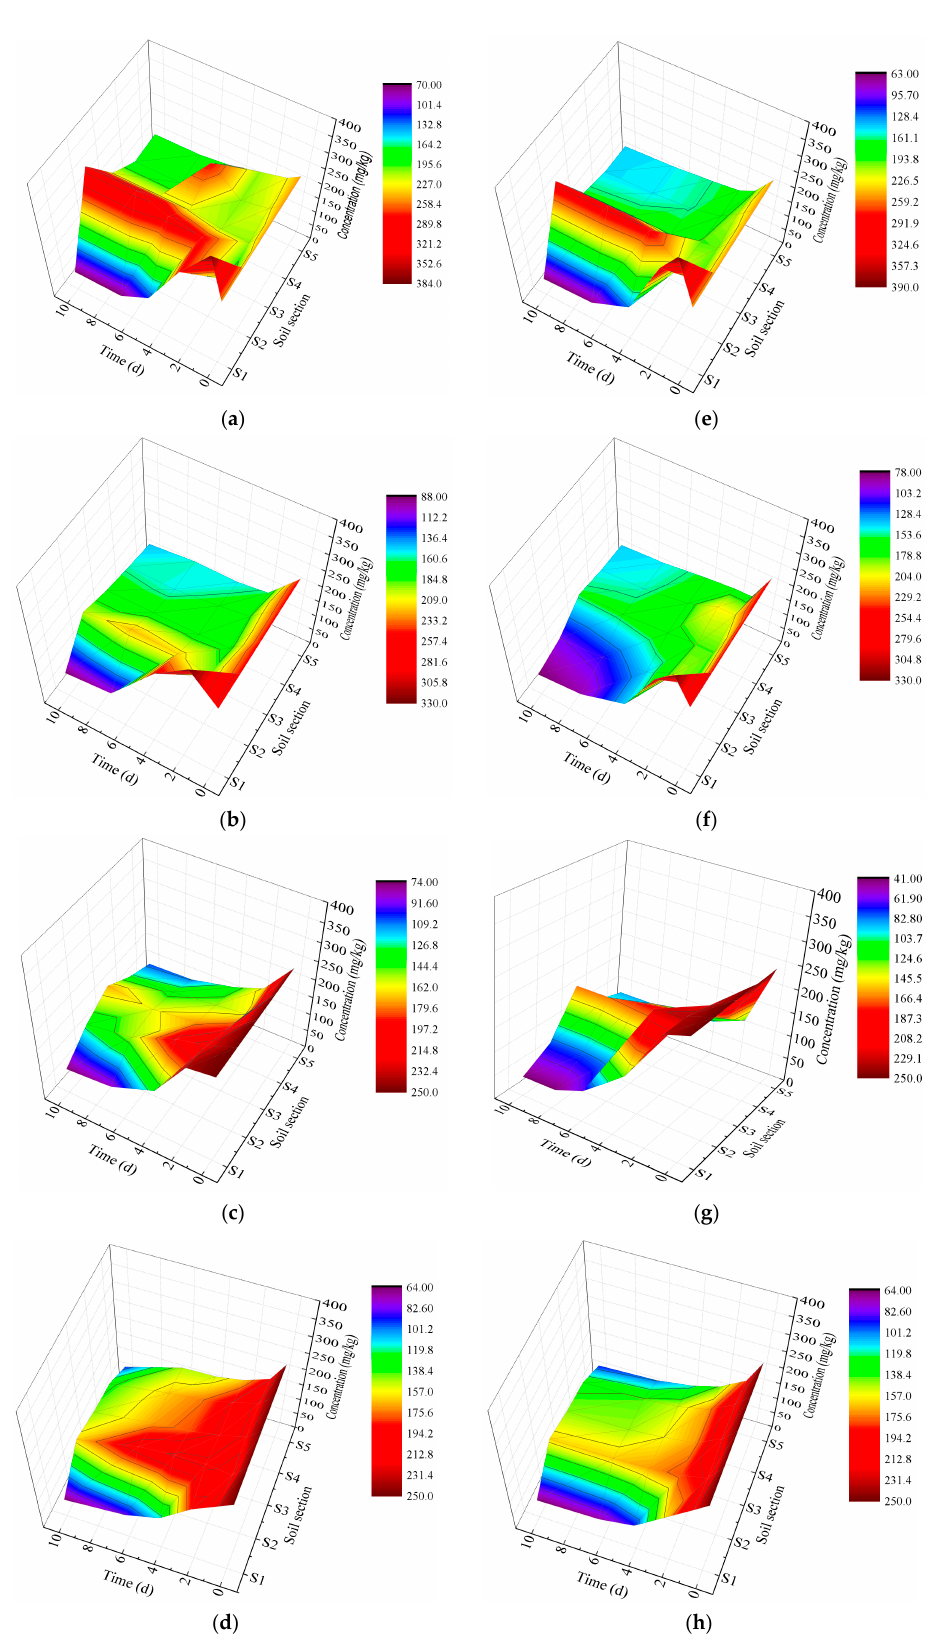
Figure 5. Changes in concentration of contaminants during electrokinetic remediation. ( a ) T1; ( b ) T2; ( c ) T3; ( d ) T4; ( e ) T5; ( f ) T6; ( g ) T7; ( h ) T8. As remediation time goes on, the maximum concentration of Cu ions occurs in the S2-S4 sections because the soil near the anode is gradually acidified, causing the Cu accu- mulation region to migrate inward gradually. The accumulation range and amount of Cu are affected by the electrolyte solution. Cu accumulations for the cases of CA and PASP are less than those of KCl and HAc by comparing the residual amount of Cu during the remediation period. This indicates that the removal efficiencies of Cu are better when CA and PASP are used as electrolytes. This is because CA and PASP, as ideal metal complex- ing agents, can be applied to a wide range of pH values, and the chemical properties of the metal complexes formed by them are stable. The removal rates, η , of Cu in the soil after the 10-day remediation of the EK and EK- PRB tests of the four electrolytes are plotted in Figure 6, which is more distinctly observed than the removal efficiencies of Cu under the conditions of various electrolytes and the addition of PRB. The application of PRB is more beneficial to the removal of heavy metals in the soil compared to EK alone. Both the amount and range of Cu accumulation reduce. The removal efficiencies for the four electrolytes increase by 56%, 40%, 22%, and 36%, respectively. In the process of EK remediation alone, copper ions and soluble salts in the soil move directionally and attach to the electrode surface under the action of the electric field, increasing the resistance of the electrode and reducing the electrical conductivity, which influences the efficiency of electrokinetic remediation. Conversely, steel slag PRB has a high adsorption capacity for Cu ions and soluble salts, which can avoid polluting electrolytes. In addition, steel slag can absorb hydroxide ions generated by the cathode, reduce the soil pH value, and avoid the formation of Cu(OH) 2 that block the soil pores. Compared with the EK tests (T1–T4), the removal efficiency increased significantly after using PRB (T5–T8).